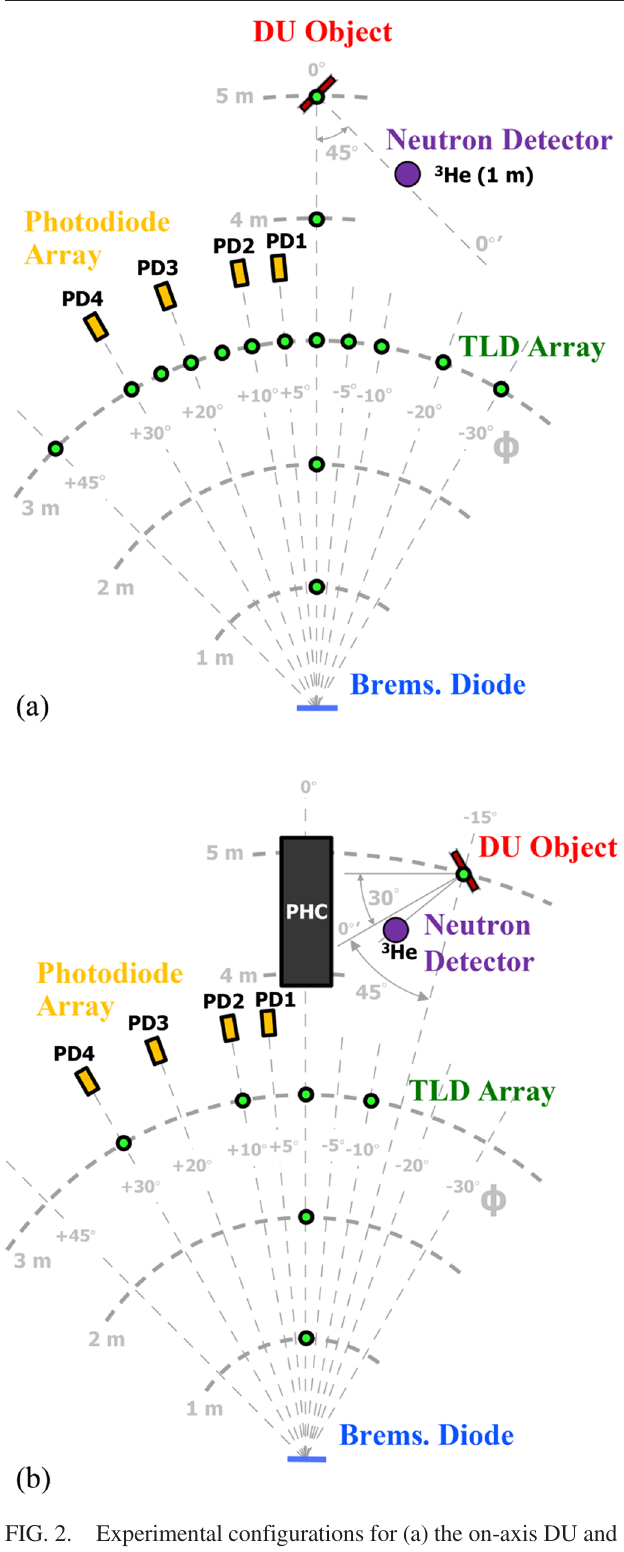
FIG. 2. Experimental configurations for (a) the on-axis DU and (b) the on-axis PHC diagnostics. Thermoluminescent dosimeters are shown as small circles and the He-3 delayed neutron detector is shown as a larger circle. The photodiode array is represented by small rectangles and was located along the 3.5 m radius from the converter. Both (a) and (b) are not precisely to